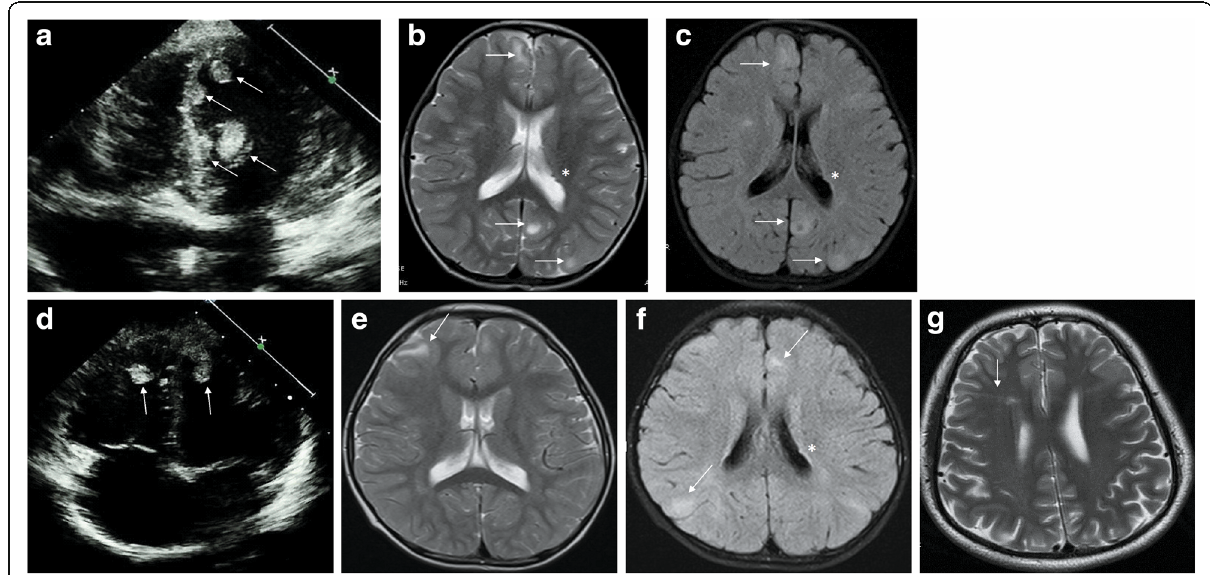
Fig. 1 Echocardiogram and magnetic resonance imaging. Echocardiogram indicates multiple cardiac rhabdomyomas (arrows) in the ventricles. ( a proband; d younger brother). Brain MRI shows multiple cortical tubers (arrows) and small subependymal nodules (*). ( b - c proband; e - f younger brother; b , e T2 weighted imaging; c , f T2-tirm-tra-dark-fluid imaging). Axial T 2 MRI of the brain demonstrates a central white matter radial migration line (arrow) in the father ( g